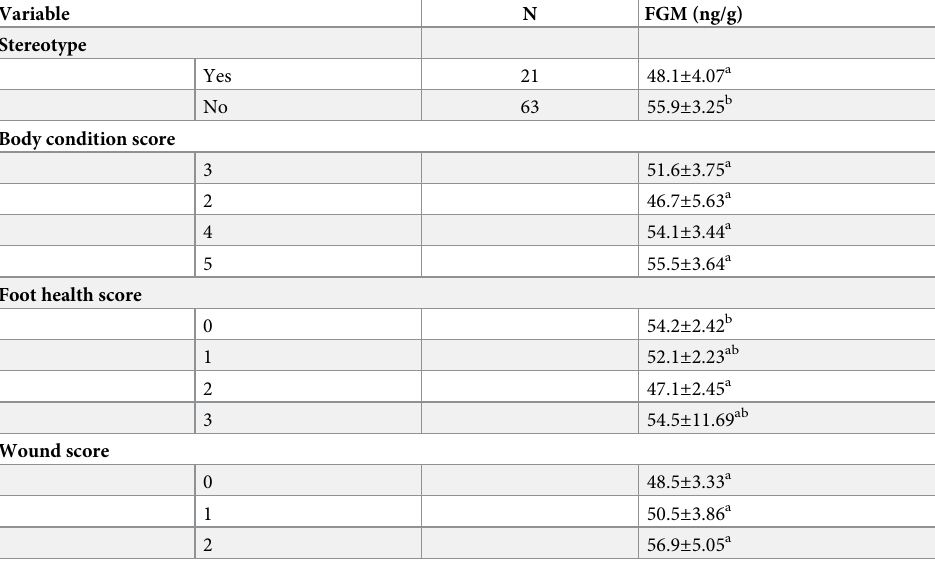
Table 7. LS-mean ( ± SEM) fecal glucocorticoid metabolite (FGM) concentrations of elephants in each category of stereotypic behaviors, BCS, FS, and WS from multivariable GEE